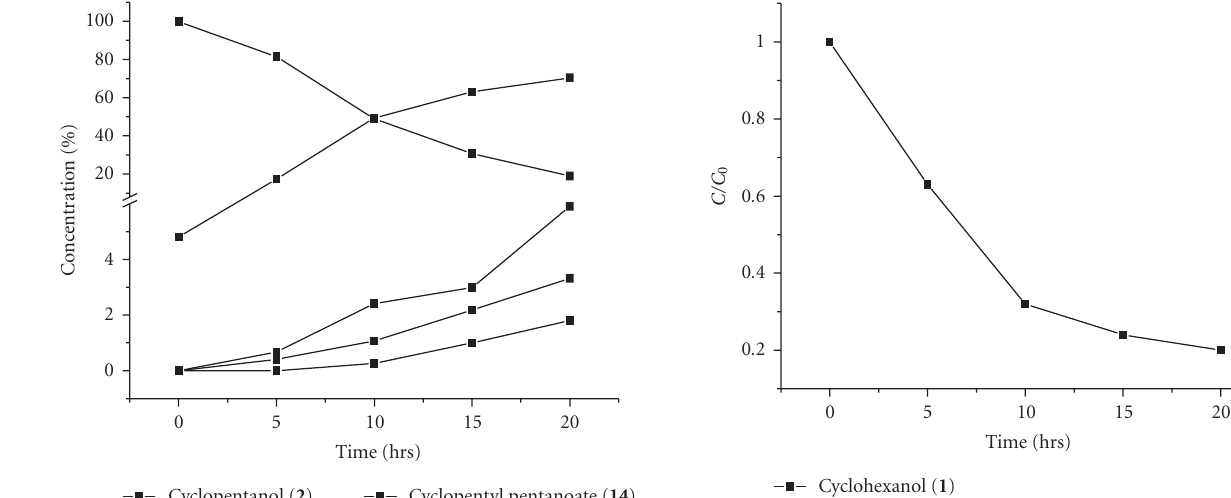
Figure 6: Photocatalytic disappearance of 1 in acetonitrile.